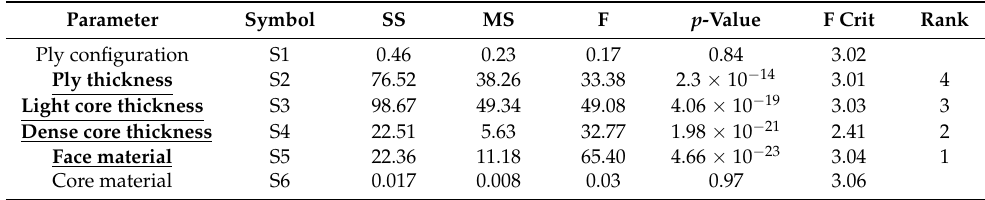
Table 10. ANOVA analysis for sandwich panel parameters for SSF. Significant parameters are highlighted in bold and underlined. Order of sensitivity is indicated under